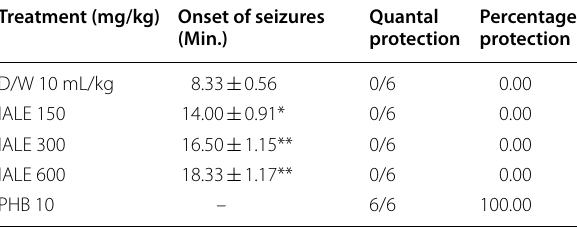
Data are presented as Mean S.E.M., * p < 0.01, ** p < 0.001 as compared ± = = to D/W group—One-way ANOVA followed by Dunnett’s post hoc test, n compared to D/W group, D/W Distilled water, IALE Ipomoea asarifolia leaf = = extract, PHB Phenobarbitone =